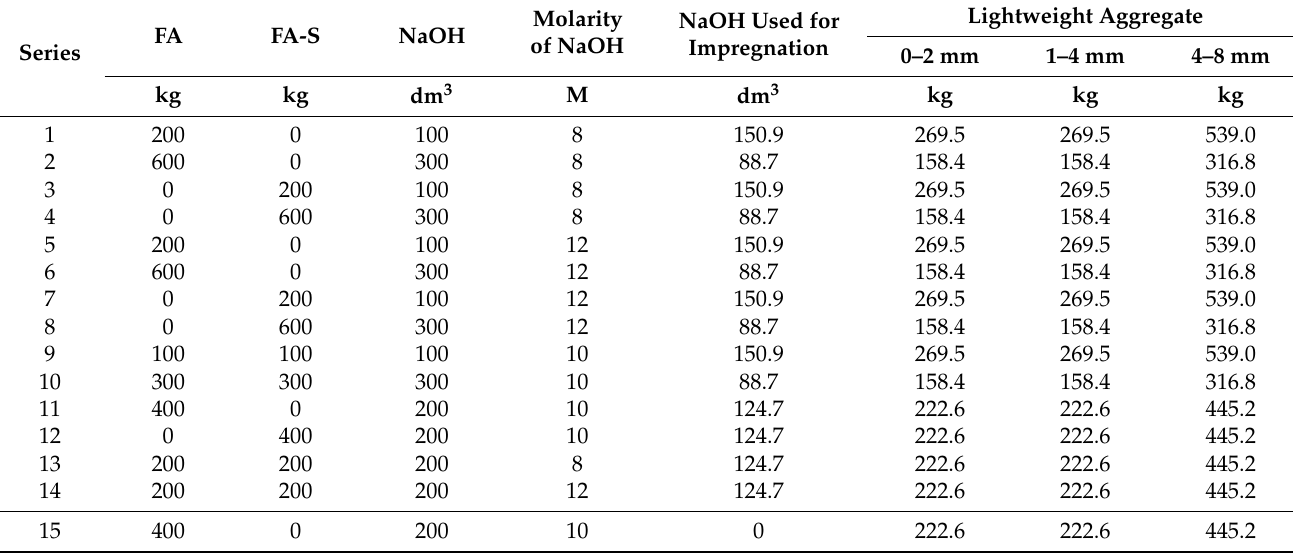
Table 7. The geopolymer mixtures per 1 m 3